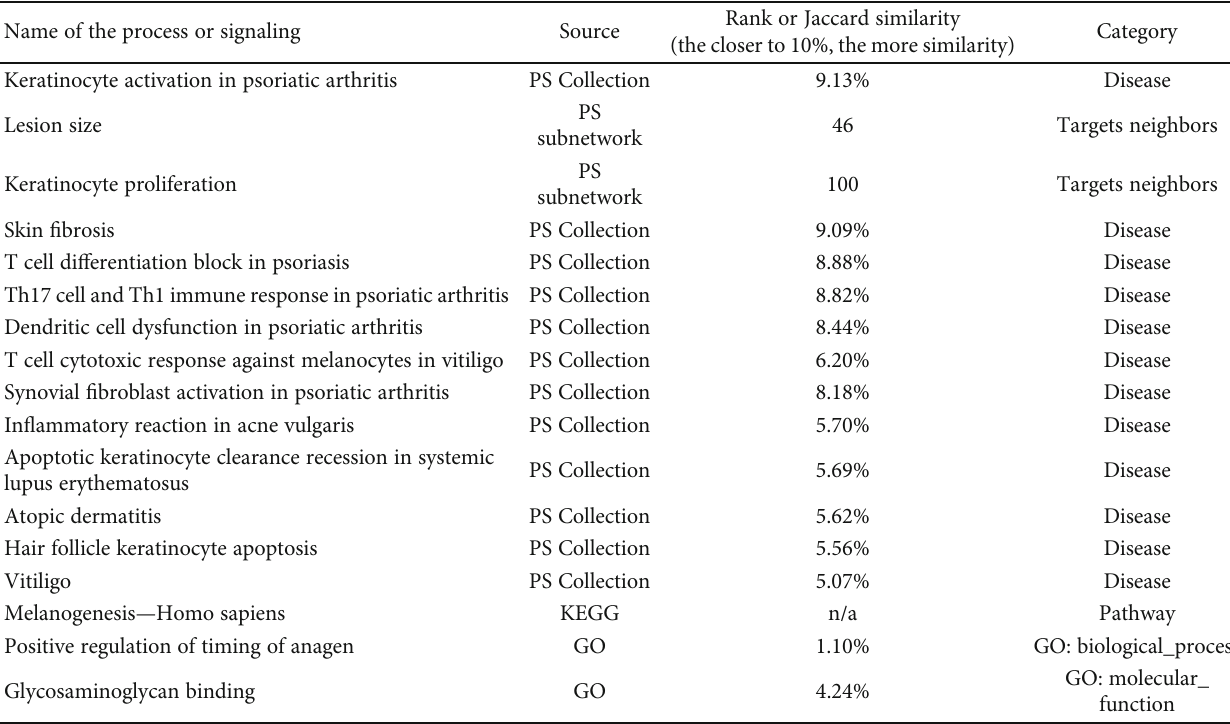
Table 1: Cell processes directly related to psoriasis and enriched with genes and proteins from the PPAR γ -downregulated signaling. See complete results with additional statistics in supplemental materials, “ PPRAG network analysis ” fi